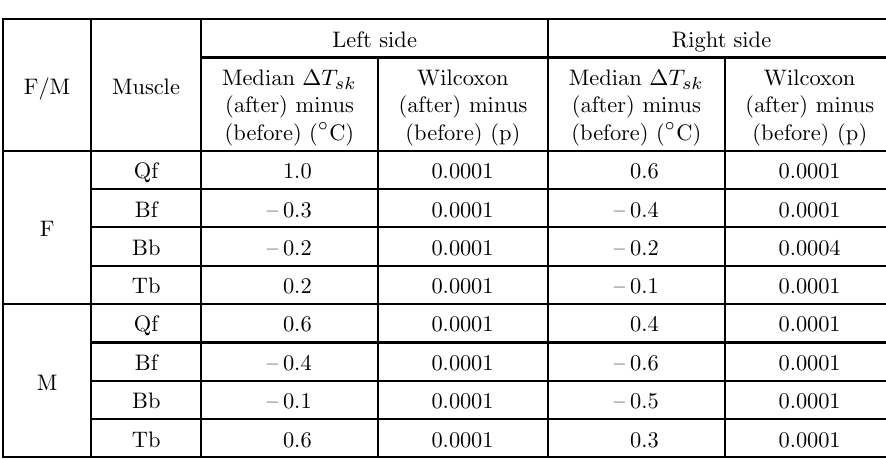
Table 6. Relative temperature RT sk of muscle areas before and after RT ( n = 18)